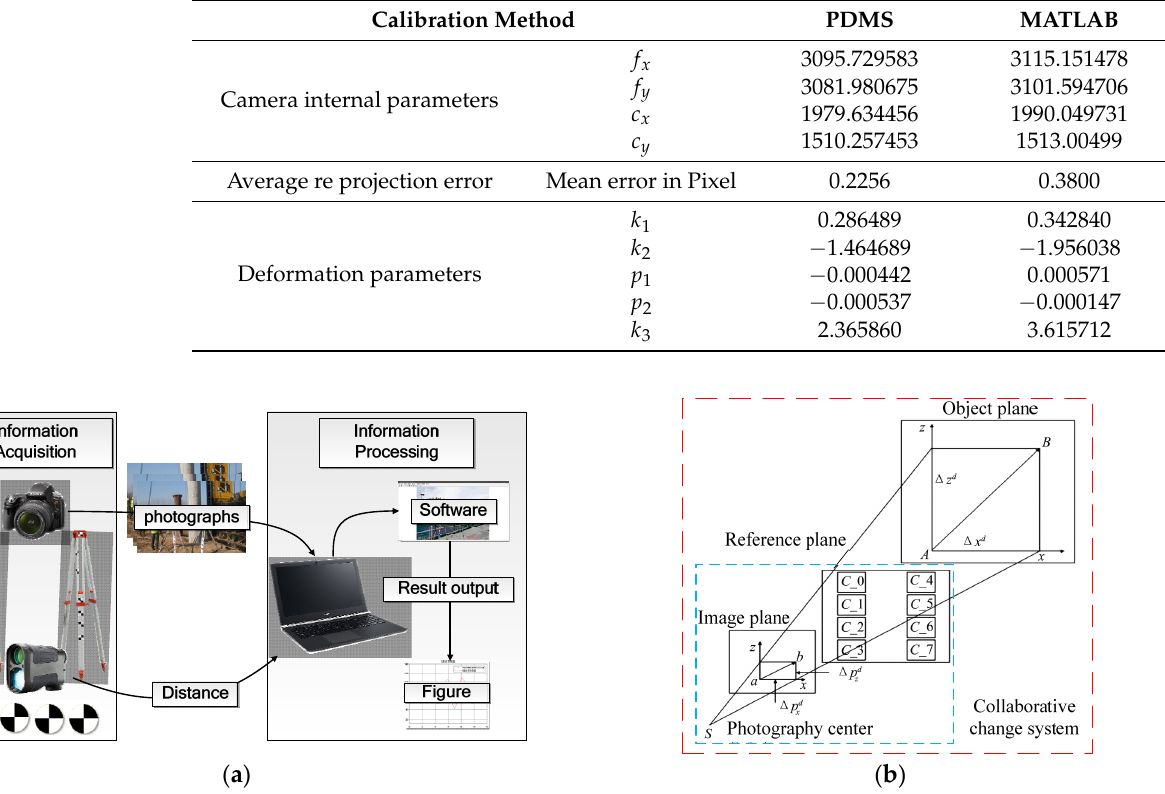
Figure 4. Geological location of the project. Through field geotechnical explorations, the strata in the study area were found to be plain fill, plain fill, silt, silty clay, aleurite, silt, aleurite, fine sand, and silt, respectively (Table 2). Among them, the seventh layer of fine sand was relatively thick, and it was one of the choices for use as the bearing stratum at the pile end.